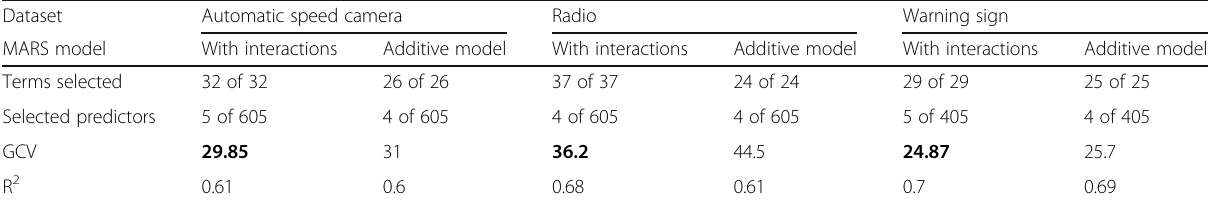
Table 1 Results of two MARS analyses (with interactions or as an additive model without interactions) on three datasets: automatic speed camera, radio and warning